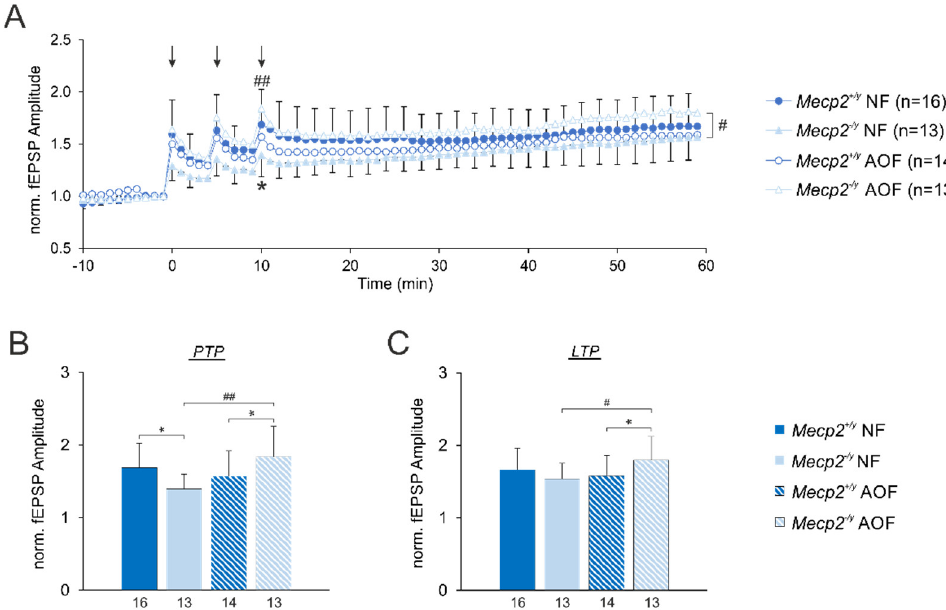
Figure 7. AO treatment improved synaptic plasticity in Mecp2 −/ y mice. ( A ) The summary of the synaptic plasticity experiments depicts the normalized fEPSPs of the four male mouse groups. Arrows indicate the high-frequency stimulation (100 Hz, 1 s duration) applied to evoke short-term plasticity (post-tetanic stimulation (PTP)) as well as long-term plasticity (LTP). ( B ) The extent of PTP was quantified right after the 3rd stimulus train, and it was significantly reduced in Mecp2 −/ y mice receiving normal food (NF) as compared with WT males. AO treatment fully reinstated PTP in Mecp2 −/ y mice. The number of mice studied is indicated below each bar; shadings and patterns apply to panels B and C. ( C ) High-frequency stimulation induced stable LTP in all groups. After 60 min of recordings, LTP in Mecp2 −/ y mice only tended to be slightly lower than that in WT males. Nevertheless, AO treatment significantly increased the extent of LTP in Mecp2 −/ y mice. The significance of the PTP and LTP changes observed was assessed by two-way ANOVAs followed by all-pairwise Holm–Sidak post-hoc tests. Genotype-related differences are indicated by asterisks (* p < 0.05), and treatment-mediated differences are indicated by crosshatches (# p < 0.05, ## p < 0.01).